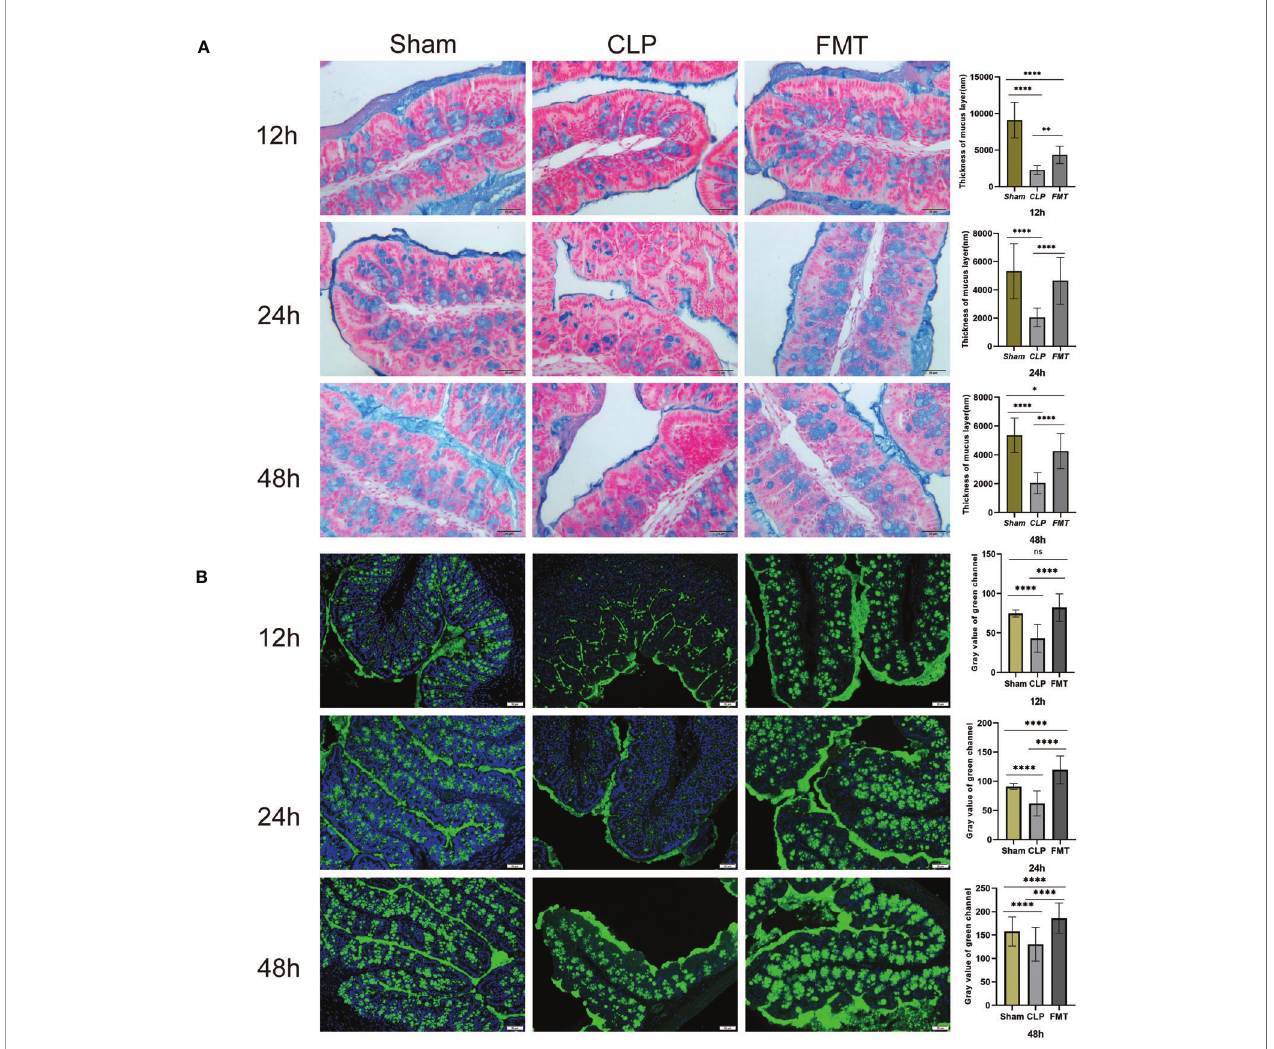
FIGURE 3 | The mucus layer thickness and MUC2 expression in the Sham, CLP, and FMT groups at 12, 24, and 48 h. (A) The AB-PAS method was used to measure the thickness of the mucus layer in the Sham, CLP, and FMT groups at 12, 24, and 48 h under a digital microscope (20 × 10). The blue color indicates goblet cell secretion and a mucus layer. The histogram on the right shows the statistical results of the comparison of the three groups. There was no signi fi cant difference between the Sham group and the FMT group in mucus layer thickness at 24 h. (B) MUC2 expression (green fl uorescence) was observed in the three groups at 12, 24, and 48 h. The histogram shows the statistical results of all three groups. There was no signi fi cant difference between the Sham group and the FMT group at 12 h. * P < 0.05, ** P < 0.01, **** P < 0.0001, ns, no signi fi cant